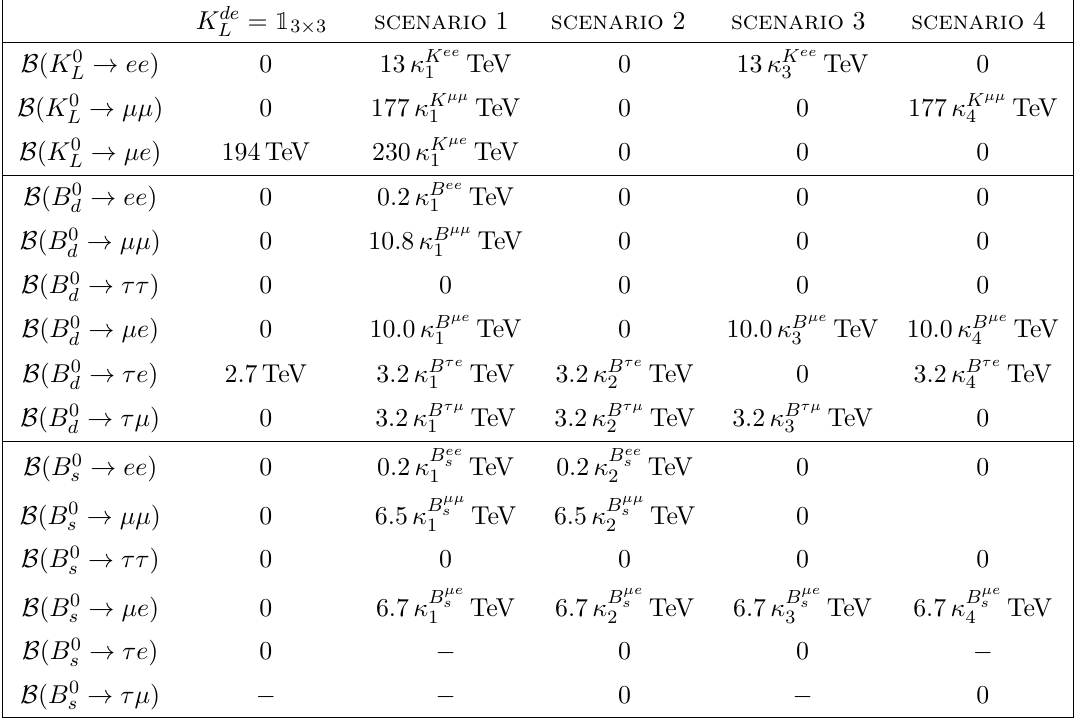
Table 7 . Limits on the gauge leptoquark mass m X compared to current measurements (or upper limits) for the mesons K 0 , B 0 and B 0 in the chiral limit (e.g. c = 0 ) where all decays are now θ R s L d helicity suppressed. Eeach scenario is given by eqs. (3.3), (3.5), (3.7) and (3.9) respectively. As all decays are now helicity-suppressed, the dominant decay channel in scenario 1 will arise from K 0 → µe unless forbidden by a specific choice of κ . As Scenario 2 completely suppresses the L decays of K 0 and now the decays of B 0 are helicity-suppressed, the limits on the leptoquark mass L d/s quite substantially decrease, similarly the limits from scenarios 3 and are significantly